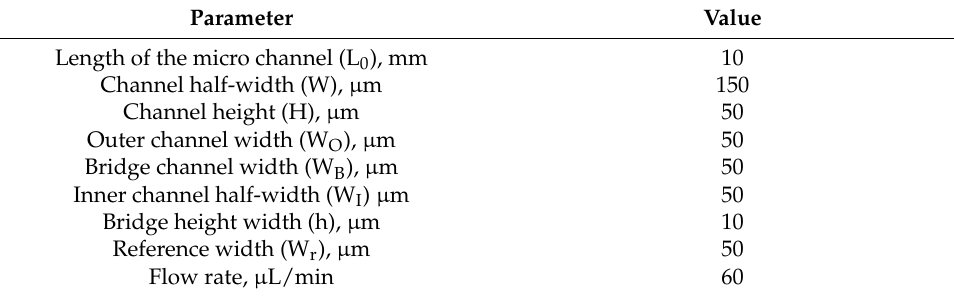
Figure 1. Configuration of double-bridge shaped MMFC channel. ( a ) Flow channel, ( b ) channel cross-section (grey regions indicate electrodes) [30]. Table 1. Specifications of the reference channel.